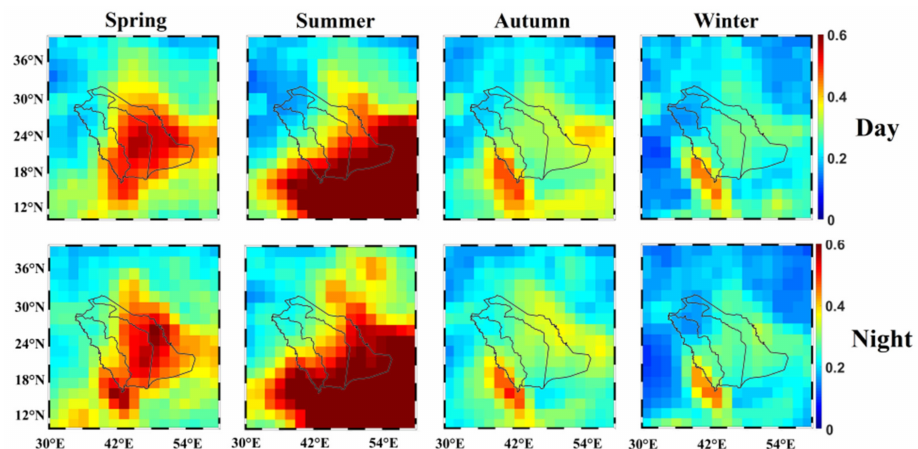
Figure 5. Seasonal spatial distributions of AOD S over Saudi Arabia from 2007 to 2019.